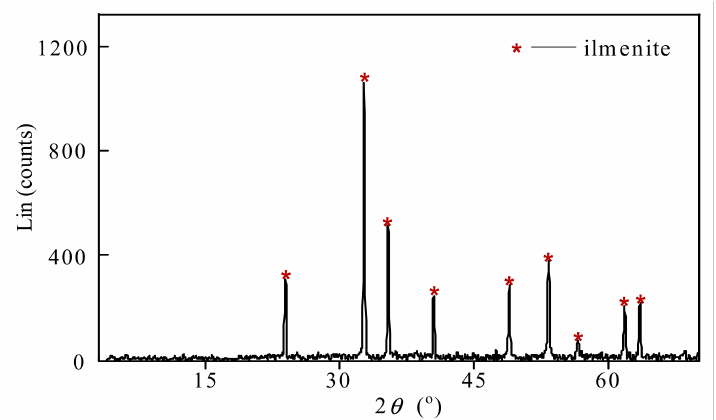
Figure 1. The XRD patterns of the ilmenite